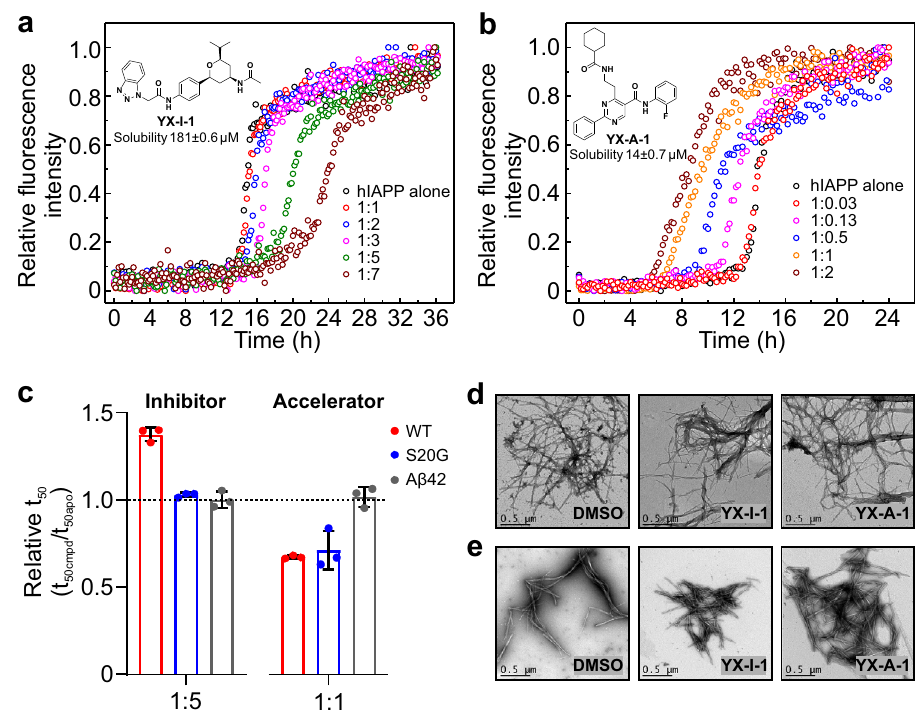
Fig. 4 Small-molecule modulators which alter the aggregation kinetics of hIAPP. a Dose-dependent inhibition of wt hIAPP aggregation by YX-I-1. Relative ThT fl uorescence intensity of 10 μ M wt hIAPP in the absence (black) or presence of a 1:1 (red), 1:2 (blue), 1:3 (pink), 1:5 (green) or 1:7 (wine) molar ratio of wt hIAPP to YX-I-1 (25mM sodium phosphate, pH 6.8, 30°C, quiescently). Inset shows the chemical structure of YX-I-1 and its solubility. b Dose-dependent acceleration of wt hIAPP aggregation by YX-A-1. Relative ThT fl uorescence intensity of 10 μ M wt hIAPP in the absence (black) or presence of a 1:0.03 (red), 1:0.13 (pink), 1:0.5 (blue), 1:1 (yellow) or 1:2 (wine) molar ratio of wt hIAPP to YX-A-1 (25mM sodium phosphate, pH 6.8, 30°C, quiescently). Inset is the chemical structure of YX-A-1 and its solubility. c Relative t 50 of wt hIAPP (red), S20G (blue) or A β 42 (grey) aggregation in the absence or presence of YX-I-1 or YX-A-1. YX-I-1 delays the formation of wt hIAPP fi brils, but not S20G; while YX-A-1 enhances the fi bril formation of both IAPP sequences. The compounds have no effect on the aggregation of A β 42 (calculated from Supplementary Fig. 10c,d). X -axis indicates the molar ratio of the corresponding peptide to YX-I-1 (inhibitor) or YX-A-1 (accelerator). Relative t 50 = t 50 (compound)/t 50 (DMSO). Bars represent the mean and error bars show standard deviation ( n = 3), with values for each replicate shown as points. d TEM images of 10 μ M wt hIAPP incubated with DMSO, 50 μ M YX-I-1 or 20 μ M YX-A-1. Samples were taken from 96-well plates after ThT fl uorescence reached a plateau. Scale bar represents 0.5 μ m. e TEM images of 10 μ M S20G incubated with DMSO, 50 μ M YX- I-1 or 10 μ M YX-A-1. Samples were taken from 96-well plates after ThT fl uorescence reached plateau. Scale bar represents 0.5 μ m. Does-dependent experiments were performed twice with three technical replicates each time using different batches of the peptides. The effect of the inhibitor (hIAPP:YX-I- 1 = 1:5) and accelerator (hIAPP:YX-A-1 = 1:1) on hIAPP aggregation at single concentration was determined more than three biological replicates independently. The TEM images are consistent in all three